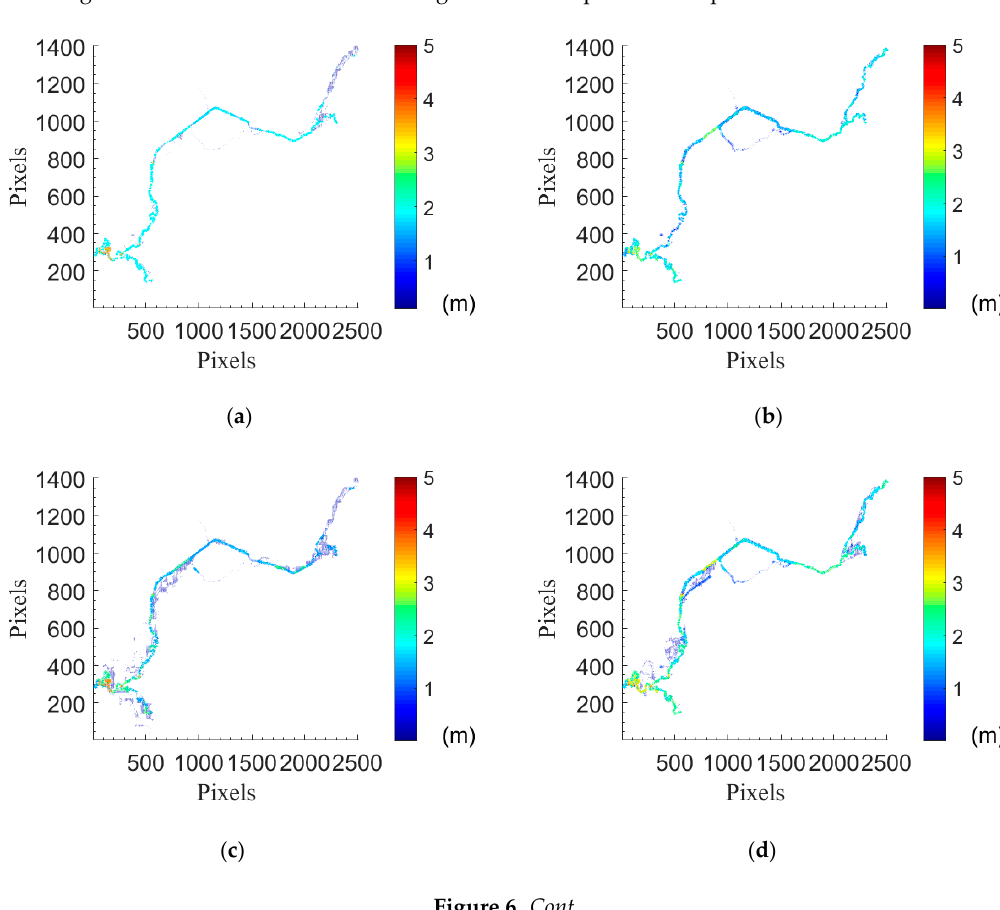
Figure 5. Hydrographs of the flood event in 2006. Seven discharge curves of three rivers and four streams are shown in different colors. Time 0 marks the start of the prediction. The dash lines upon the discharge curves mark the different discharge sections for prediction inputs.